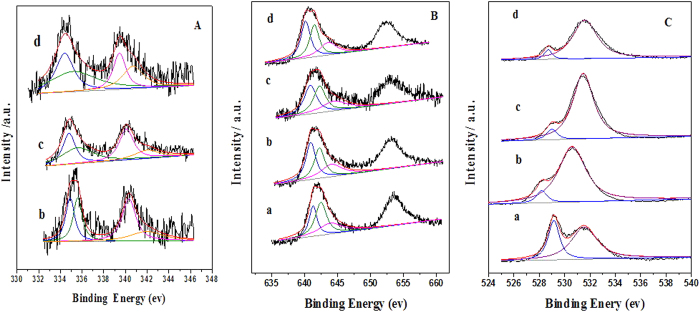
XPS spectra and curve-fitting for LSM and Pd/LSM-x catalysts(A) Pd3d5/2; (B) Mn2p3/2; (C) O1s; (a) LSM; (b) Pd/LSM-1; (c) Pd/LSM-2; (d) Pd/LSM-3.